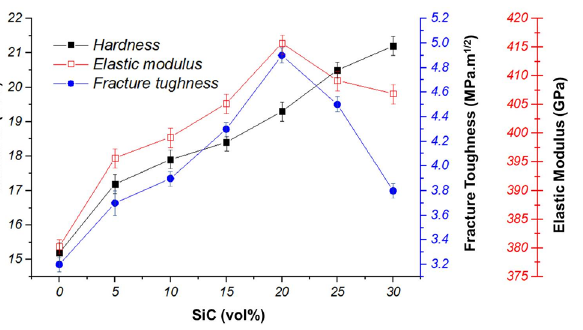
Figure 8. The variation of Vickers hardness, fracture toughness, and elastic modulus of in situ HfB 2 –SiC